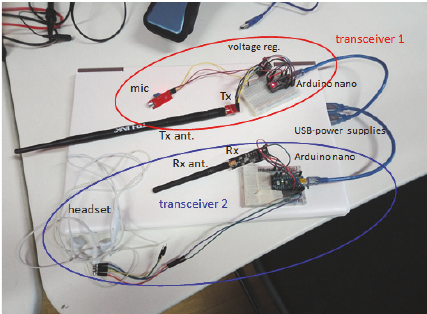
Figure 4: An early assembly of a full-duplex voice communication